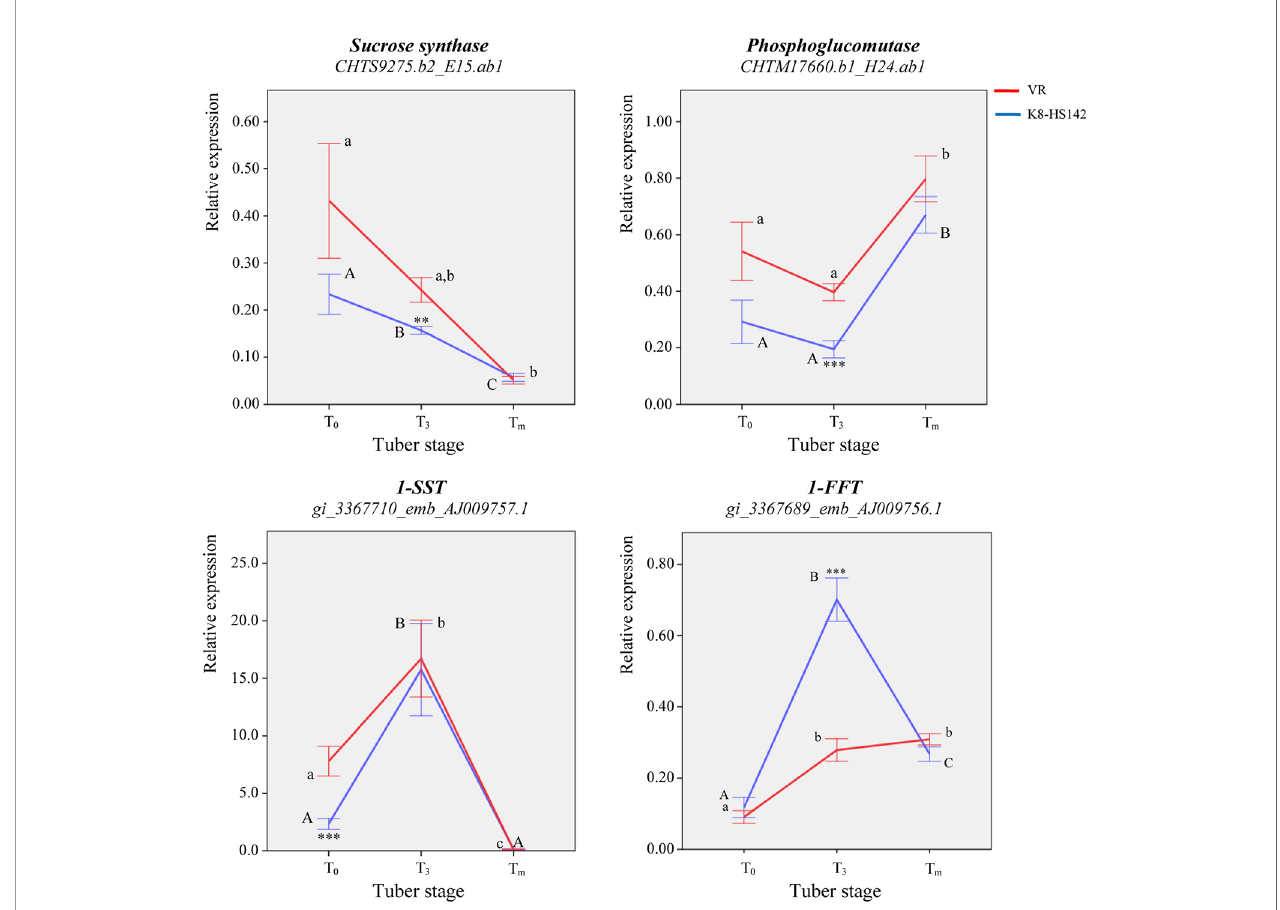
FIGURE 5 | qRT- PCR analysis of key genes ruling the metabolism of storage carbohydrates in developing tubers of Helianthus tuberosus “ VR ” and “ K8-HS142 ” clones. The temporal expression pro fi les by means of qRT- PCR at three speci fi c tuber developmental stages (T 0 , T 3 , and T m ) of genes implied in the cytoplasmatic metabolism of hexoses such as SuS and PGM, and fructan polymerization, 1-SST and 1-FFT , which were differentially expressed upon microarray analysis, are shown. The relative expression of each gene is calculated using the (2 - D Ct ) algorithm. Statistically signi fi cant differences were assessed according to a two-way ANOVA between T 0 , T 3 , and T m stages in “ VR ” and “ K8-HS142 ” (indicated as a , b , c and A, B, C, respectively). Asterisks **, *** indicate the signi fi cance of the differences of transcript levels between clones at a given tuber stage (0.01 ≤ p < 0.01 and p < 0.001, respectively). The bars indicate ±1 standard